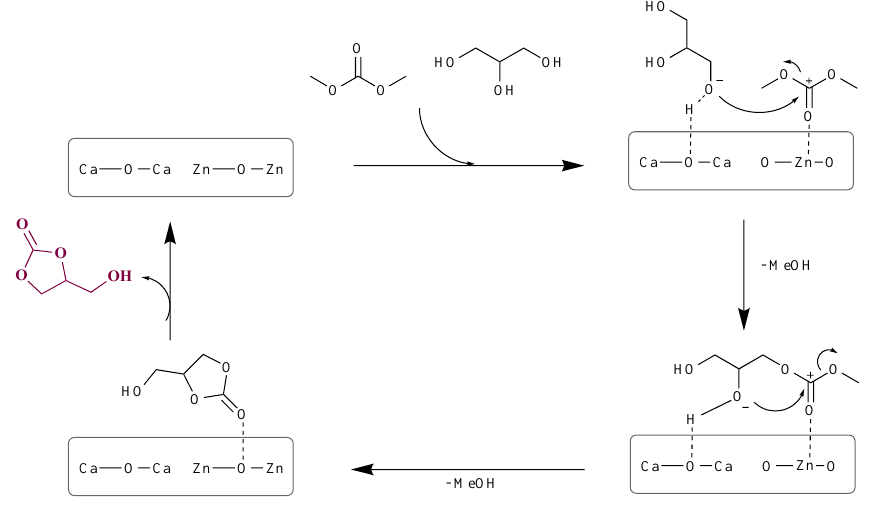
Scheme 8 . CaO–ZnO solid base catalyst for the glycerol transesterification